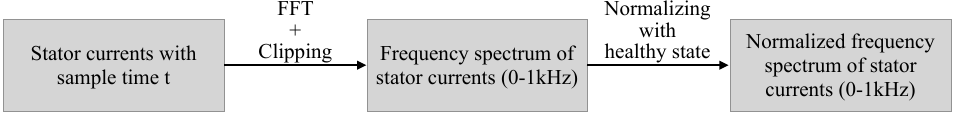
Figure 7. Sequence of the individual steps of the preprocessing with fast Fourier transformation, clipping, and normalization via the subtraction with the healthy